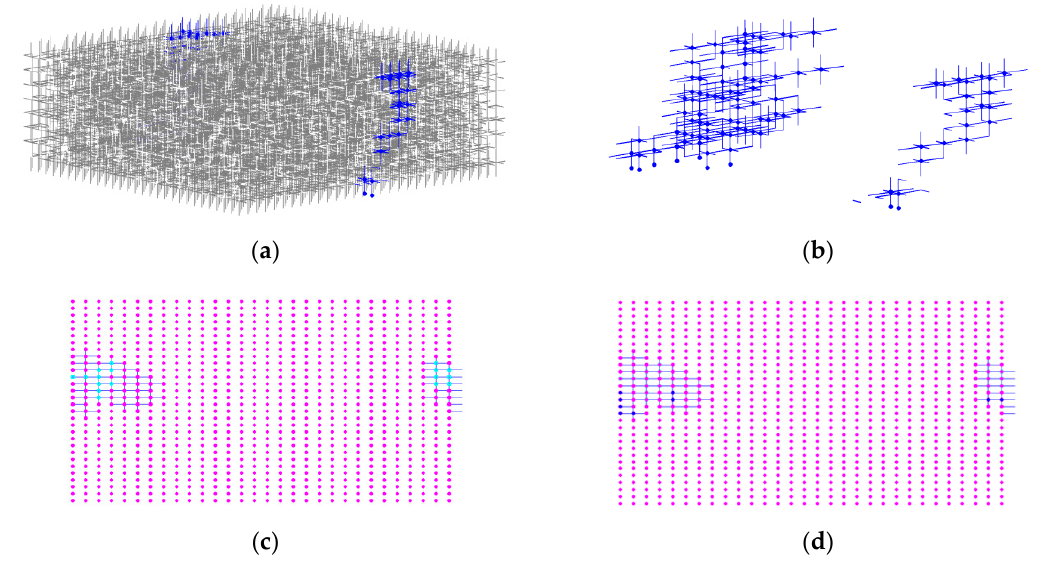
Figure 8. ( a ) PN shortly before loss of connectivity of the liquid supply route through the blue cluster. ( b ) Only the liquid transporting cluster (main cluster) is shown here. Note that due to the applied periodic boundary conditions, the cluster appears at two sides of the PN, while it is disconnected in the center. ( c ) Empty surface pores at the top side (catalyst side). Pores connected to a liquid-filled throat of the spanning cluster are shown in light blue. ( d ) Surface pores at the bottom side (water channel side). Pores connected to the spanning (main) cluster in blue; all other pores in red.